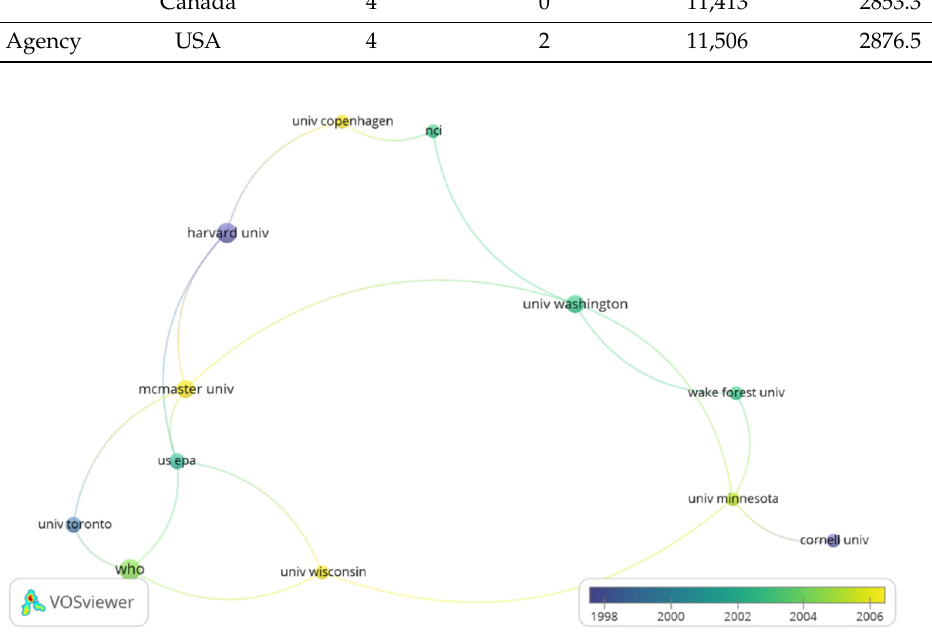
Figure 7. The institution collaboration network.